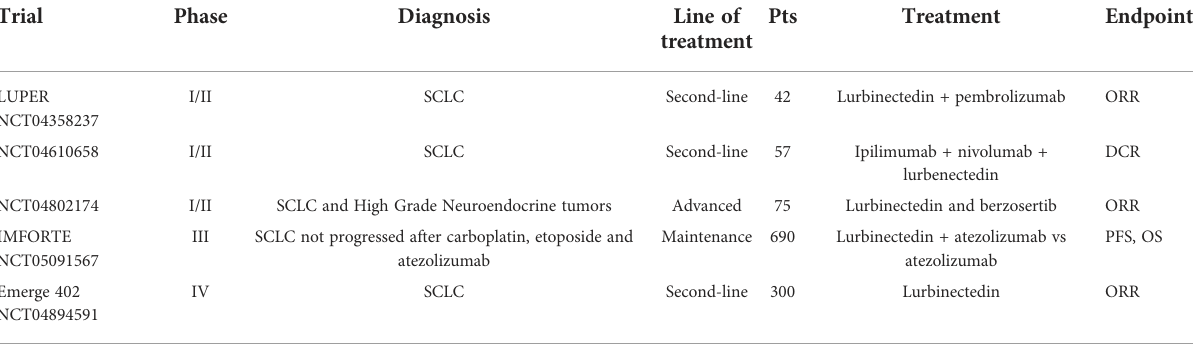
TABLE 2 Ongoing studies with